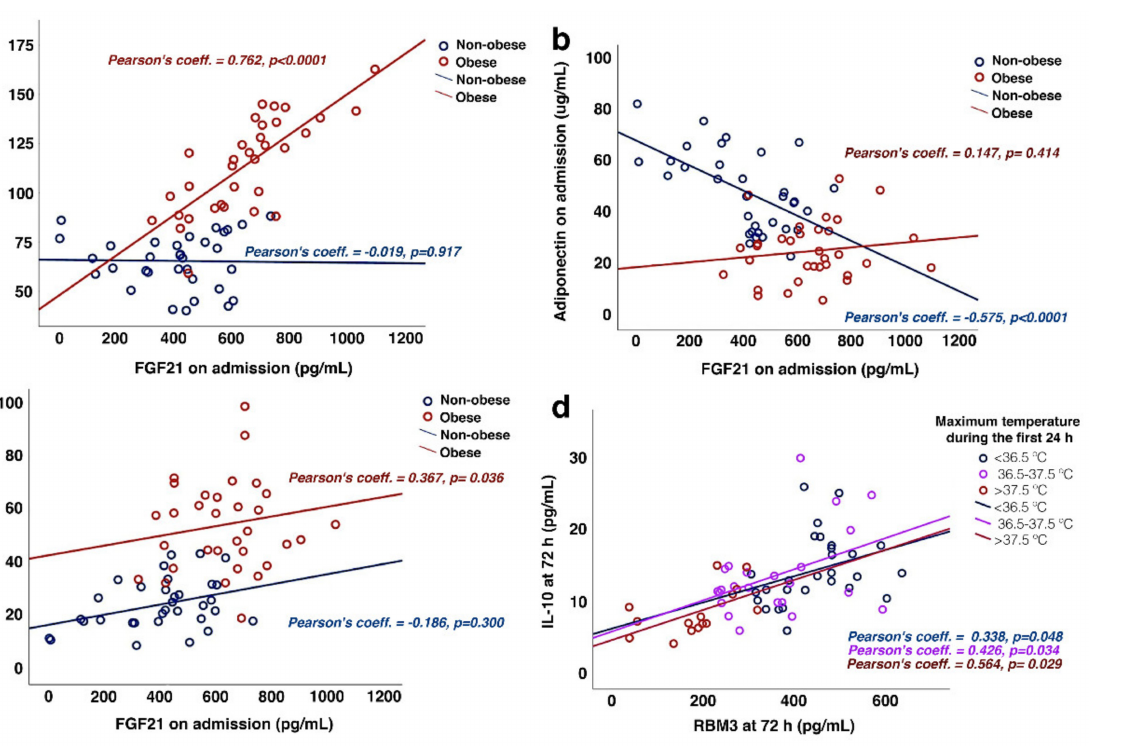
Figure 5. Association of fibroblast growth factor 21 (FGF21) and RNA-binding motif protein 3 (RBM3) with obesity and inflammatory biomarkers. ( a – c ) Association between FGF21 on admission and leptin ( a ), adiponectin ( b ), and interleukin-6 (IL-6) ( c ) concentrations in obese and non-obese participants. ( d ) Association of the circulating concentrations of RBM3 and interleukin-10 (IL-10) at 72 h with the maximum temperature during the first 24